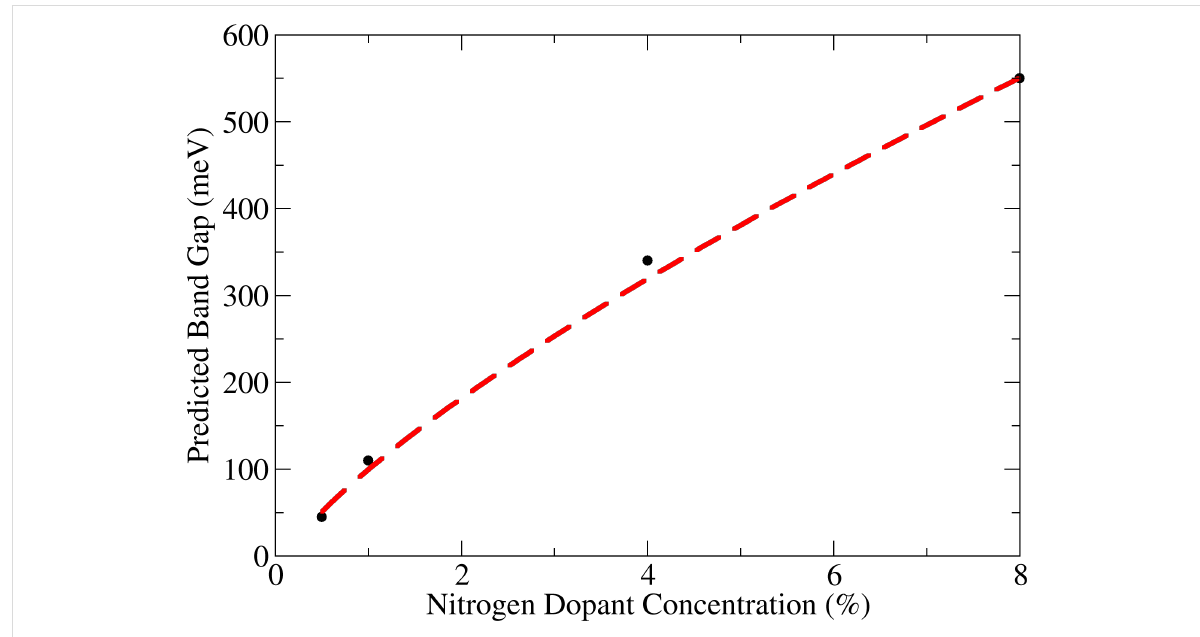
Figure 3: Predicted band gap against nitrogen dopant concentration. Black circles are calculated values from [36] and the red dashed line shows the expected band gap scaling with concentration, according to the power 3/4 as discussed in the text.